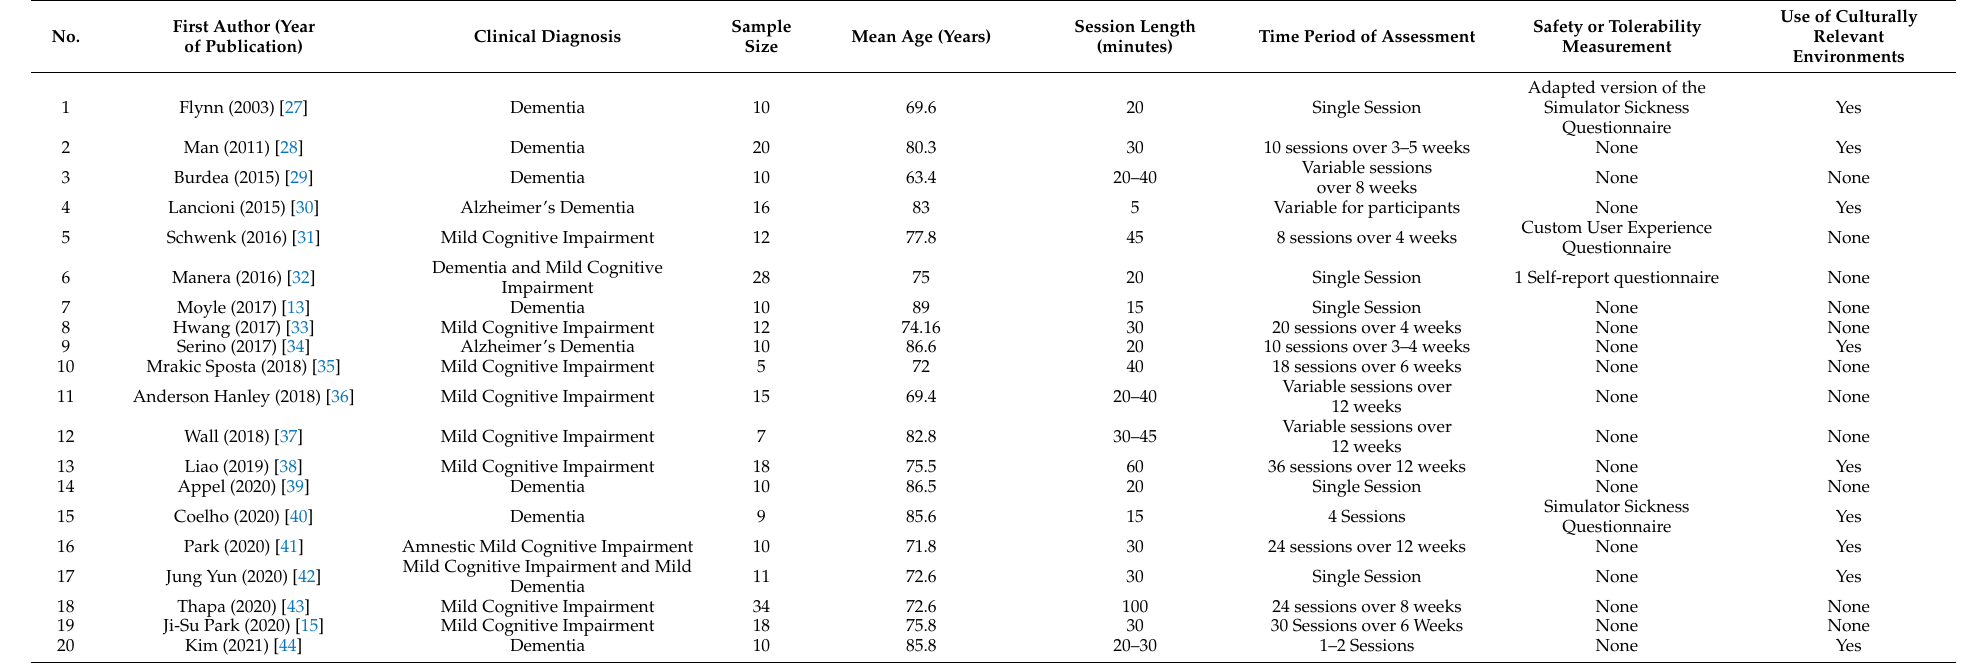
Table 2. Existing studies on the use of VR in MCI and dementia